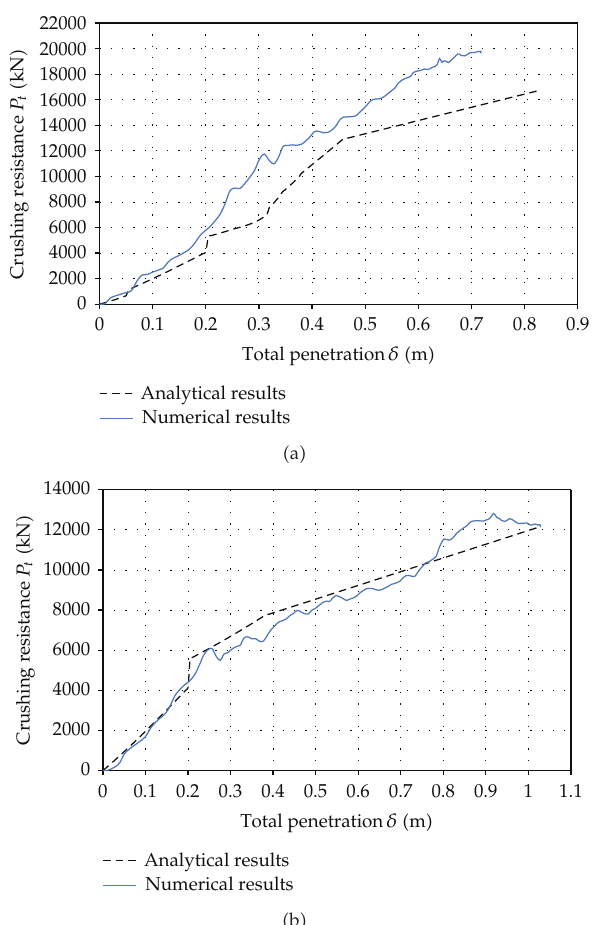
Figure 33: Comparison of the analytical and numerical crushing forces for gate